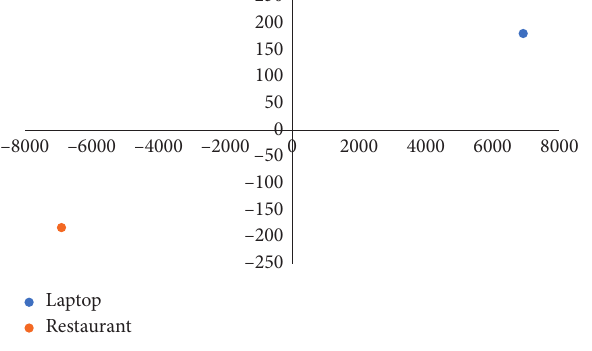
Figure 7: Final domain vectors for two domains.